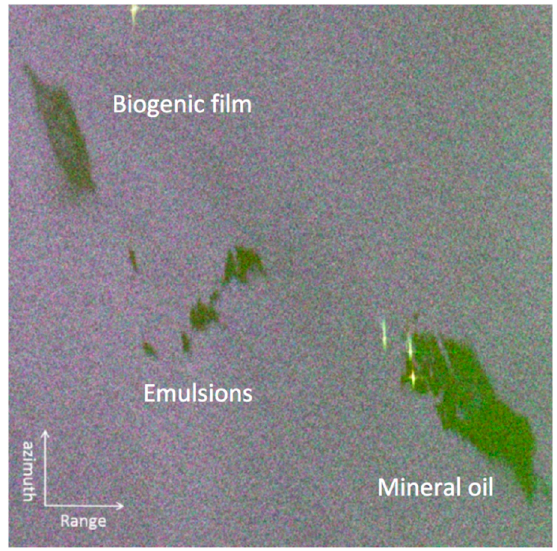
Figure 4. Pauli RGB image of RADARSAT-2 data. (RADARSAT-2 Data and Products © Macdonald, Dettwiler and Associates Ltd., Vancouver, BC, Canada, 2011—All Rights Reserved. RADARSAT is an official mark of the Canadian Space Agency).